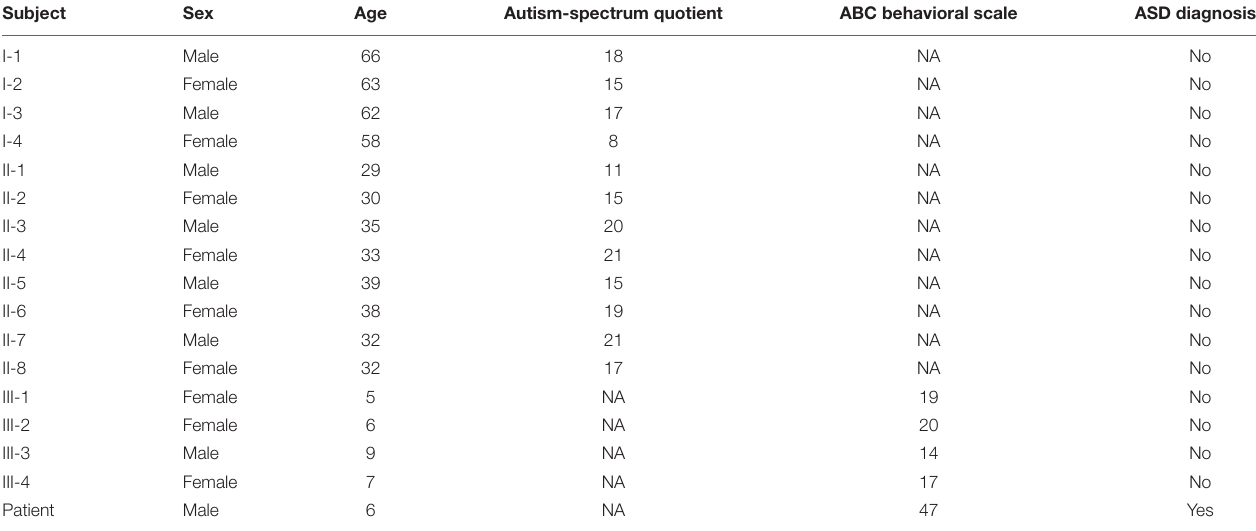
TABLE 1 | Characteristics of autism-spectrum scales for the patient’s family